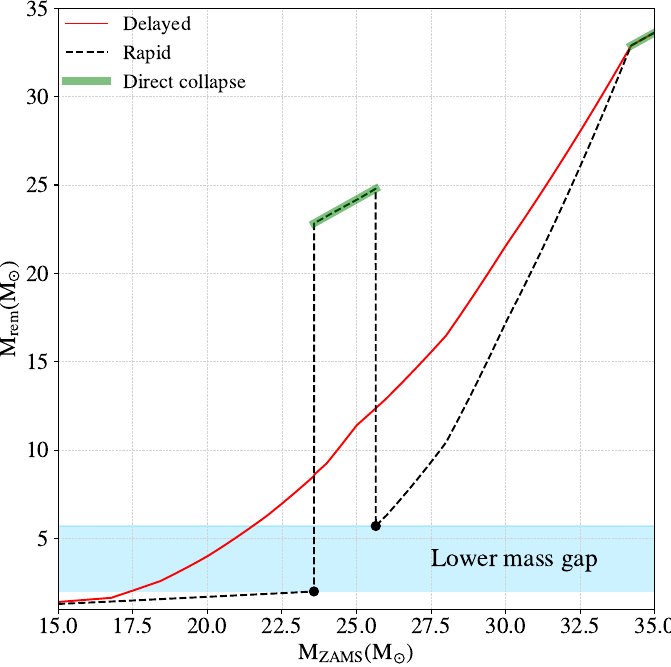
Figure 3. Mass of the compact remnant as a function of the initial mass of its progenitor star obtained with the delayed (solid red line) and the rapid (dashed black line) SN explosion model. The progenitor stars come from the SEVN code [97] with look-up tables from PARSEC [98]. The shaded cyan area shows the location of the lower mass gap, while the semi-transparent green line highlights the region where direct collapse occurs. The two black points define the lower and the upper edge of the mass